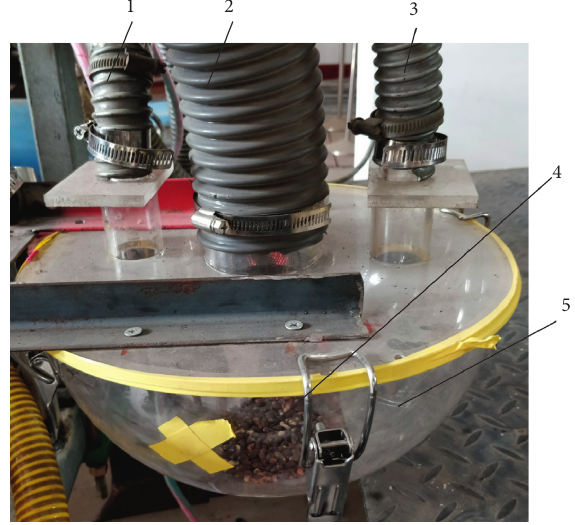
Figure 14: Waste seed storage room. (1 and 3) Interface for seed storage shell. (2) interface for vacuum fan. (4) Waste seed. (5) Waste seed storage